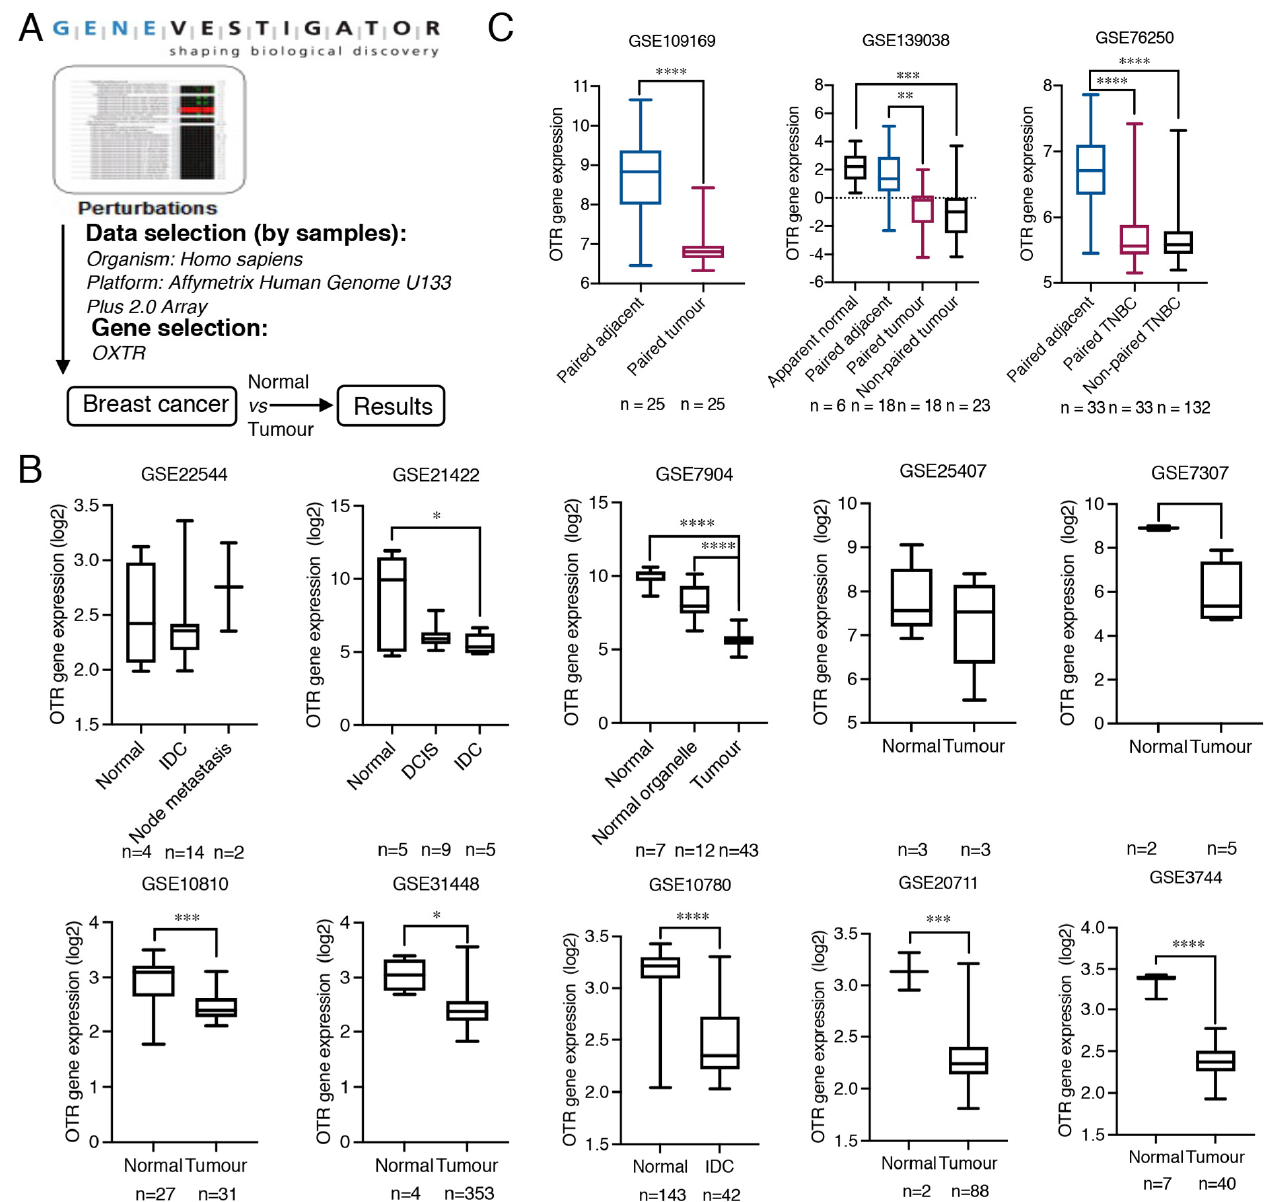
Figure 1. Oxytocin receptor gene expression analysis in normal, adjacent and, tumour breast tissue. ( A ) The workflow of the strategy to find OTR expression alteration specific to breast cancer using the Perturbations tool from Genevestigator. ( B ) Detailed OTR gene ( OXTR ) expression data (log2 transformed) comparing tumour and normal breast tissues from breast cancer RNA-Seq expres- sion datasets, based on Affymetrix Human Genome U133 Plus 2.0 Array platform, extracted from Genevestigator. DCIS, ductal carcinomas in situ, IDC, invasive ductal carcinomas. ( C ) OTR gene expression analysis of paired breast tumour and adjacent breast tissue. The datasets are based on various sequencing platforms and presented as expression data obtained from the GEO database without log2 transformation. TNBC, triple-negative breast cancer. All human patient data are ex- pressed as a min to max boxplot. The Mann–Whitney test was used to analyse non-paired samples from two groups. One-way ANOVA analysis followed by Tukey’s multiple comparison test was used to compare datasets containing more than two groups. A paired t -test was used to analyse paired tumour and normal or adjacent samples. *, p < 0.05, **, p < 0.01, ***, p < 0.001, ****, p <